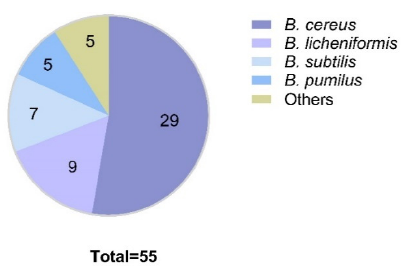
Table 1. Number of samples and bacterial isolates of different sources.